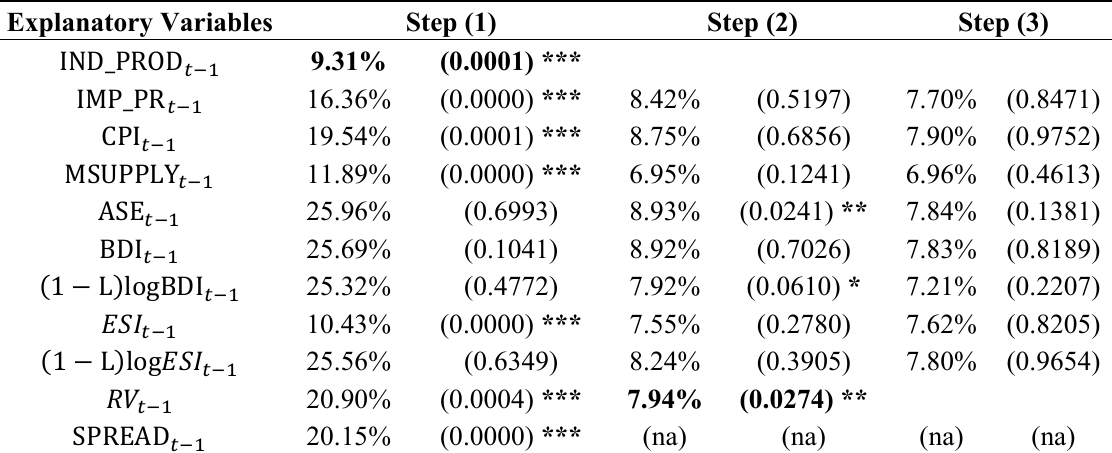
) , where (cid:2180) denotes the vector of explanatory = 1) = Φ((cid:2236)(cid:2180) (cid:2930) (cid:3047)(cid:2879)(cid:2869) (cid:3047) , IMP_PR , CPI , MSUPPLY , ASE , BDI , (1 − L)logBDI (cid:3047) (cid:3047) (cid:3047) (cid:3047) (cid:3047) (cid:3047)